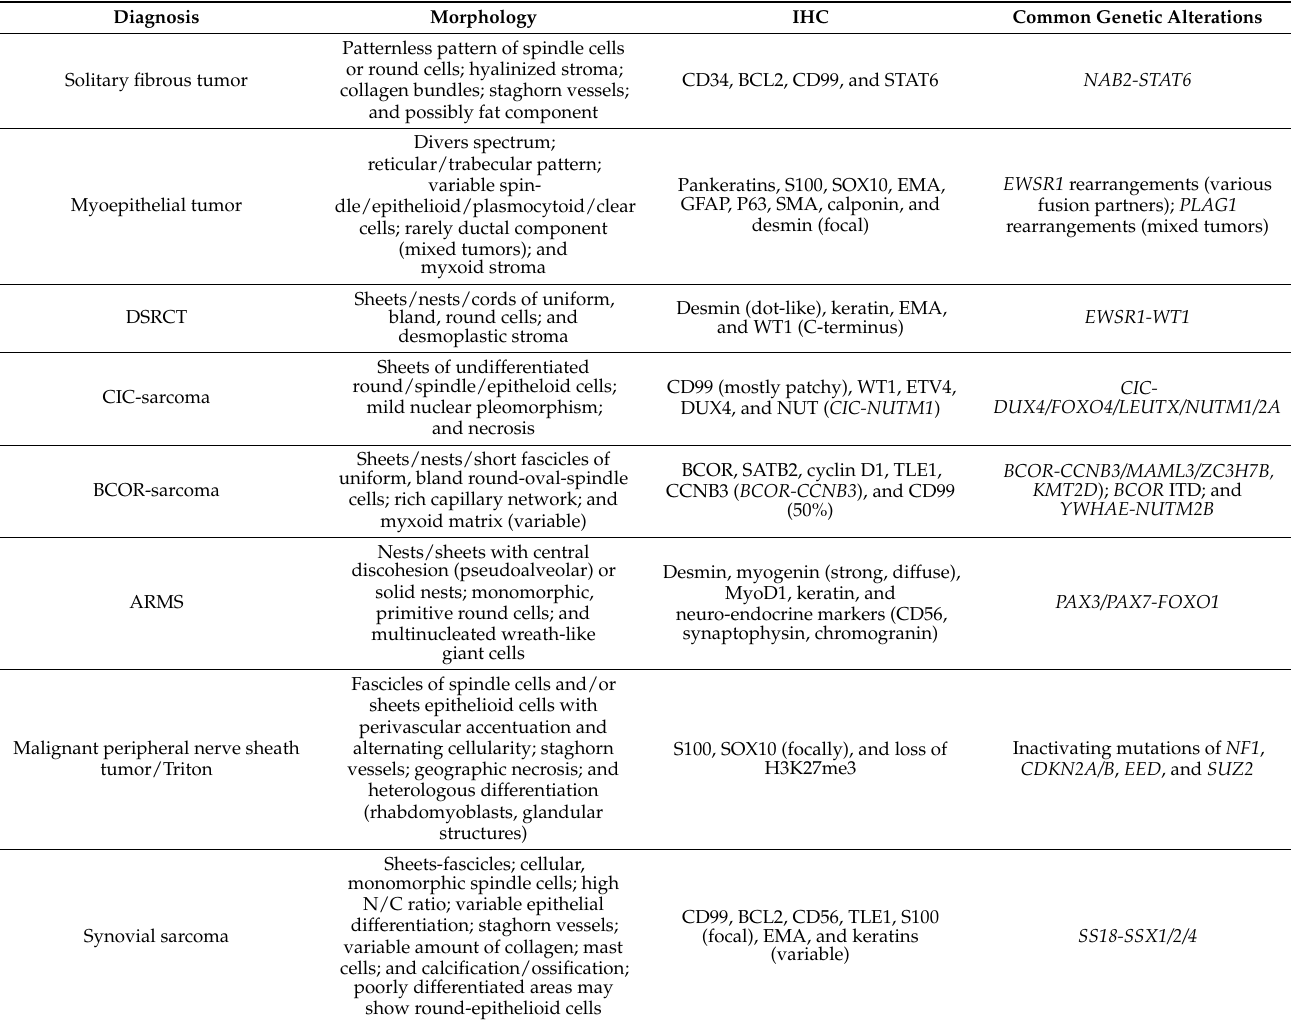
Table 2. Differential diagnoses of EWSR1 —non-ETS ( NFATC2 and PATZ )